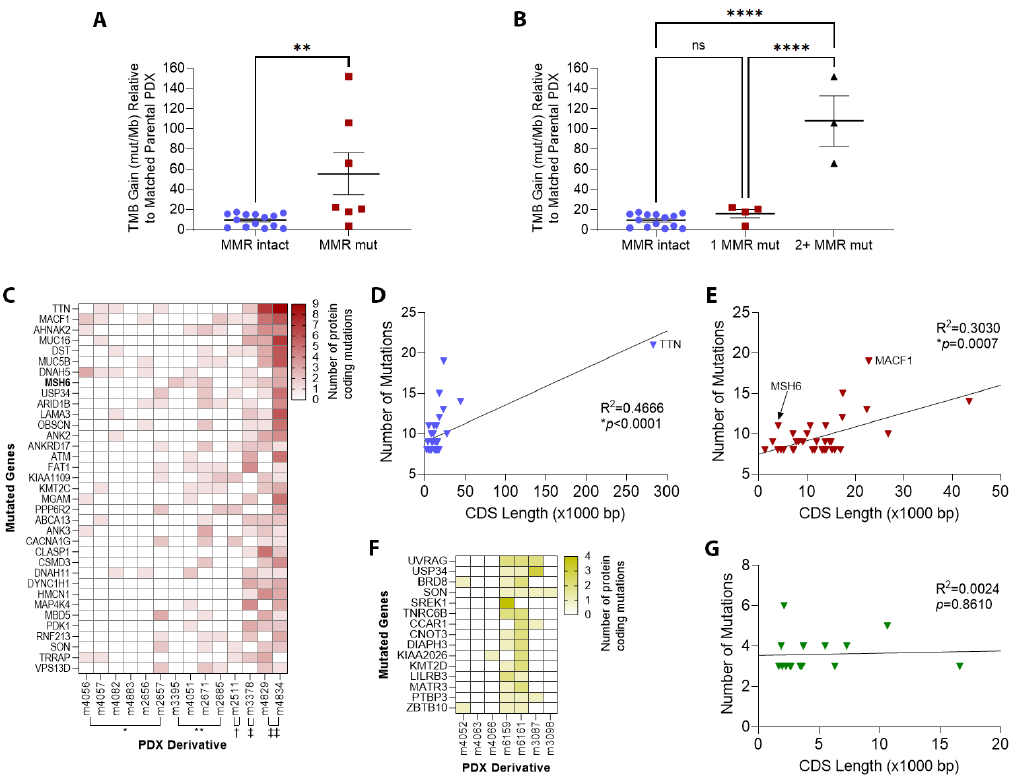
Figure 4. Tumor mutation burden (TMB) and individual gene mutations in derivative PDX. ( A ) TMB gain (relative to matched parental PDX) in derivative PDX with intact DNA mismatch repair (MMR) genes compared to derivative PDX with DNA MMR gene mutations (mut/Mb = mutations per megabase, ** p < 0.05). ( B ) TMB gain in derivative PDX with intact DNA MMR genes compared to derivative PDX with a single MMR gene mutation and two or more MMR gene mutations (**** p < 0.0001). ( C ) Heat map of the 35 most frequently mutated genes in PDX derivatives treated with TMZ (* TMZ ×1, ** RT+TMZ ×1, † RT+TMZ ×2, ‡ RT+TMZ ×3, ‡‡ TMZ ×4). ( D ) Scatterplot illustrating the frequency of protein-coding mutations in genes as a function of gene coding sequence (CDS) length in base pairs (bp). TTN has the longest CDS among human genes and was the most frequently mutated in post-TMZ PDX (* p < 0.05). ( E ) Frequency of protein-coding mutations as a function of CDS length, with TTN eliminated (* p < 0.05). ( F ) Heat map of the 15 most frequently mutated genes in PDX derivatives treated with only radiation therapy (RT). ( G ) Frequency of protein-coding mutations as a function of CDS length in PDX derivatives treated with only